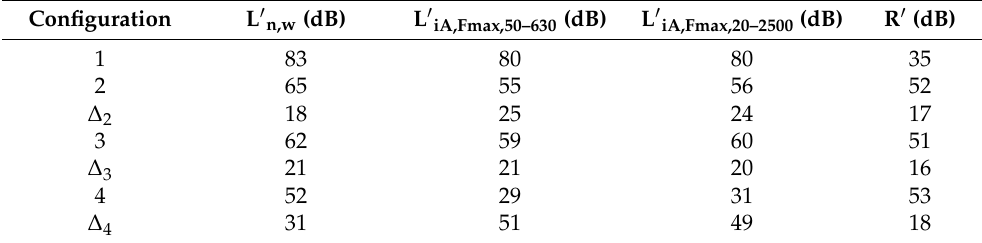
Table 6. Impact noise and airborne sound insulation weighted index results for each configuration.